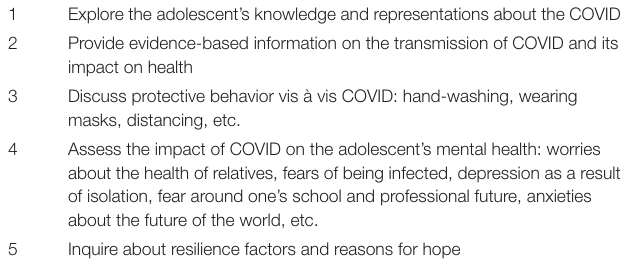
TABLE 1 | Issues to be discussed with the adolescent patient in the context of the COVID pandemics.